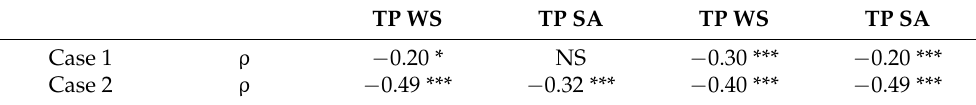
Table 6. Spearman’s rank correlation coefficient ( ρ ) between collected data in total nitrogen (TN, µ g/L) and total phosphorus (TP, µ g/L) concentrations, with the expected increase of these concentra- tions for the year 2030 scenario in Case 1 (Canelones) and 2 (Laguna del Sauce), during winter–spring (WS) and summer–autumn (SA). NS: non-significant, *: significant p < 0.05), *** significant, p < 0.001. TP WS TP